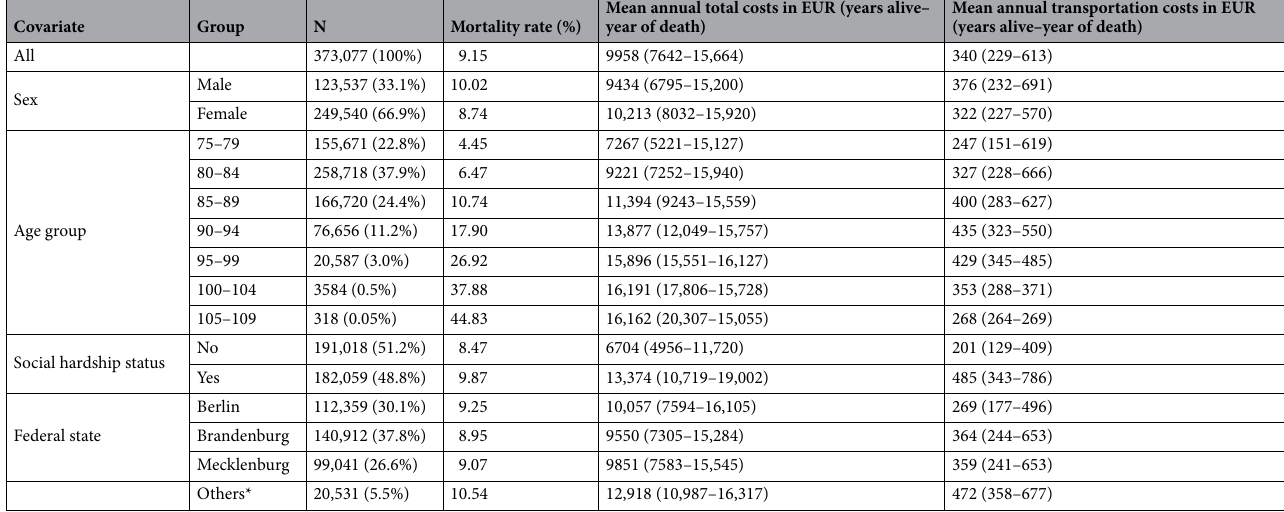
Table 1. Sample characteristics (N; %) from Northeast Germany. Total, male and female population aged 75 years or older, in 5-years age bands and according to federal state. We compare the global dataset against the sampled cohort. *“Others” indicates individuals who were insured at AOK Nordost, but did not live in the three federal states of interest.